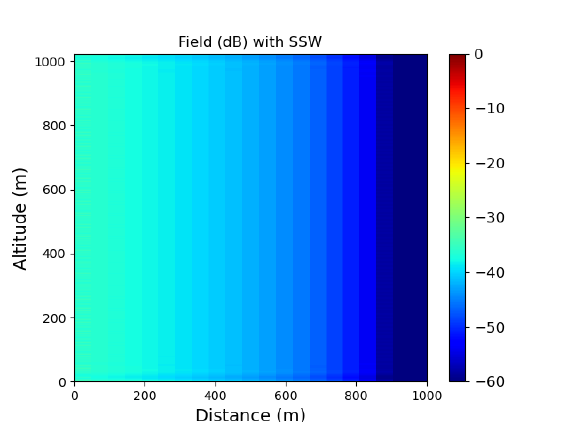
Figure 4. Normalized reduced field (dB) obtained with SSW.